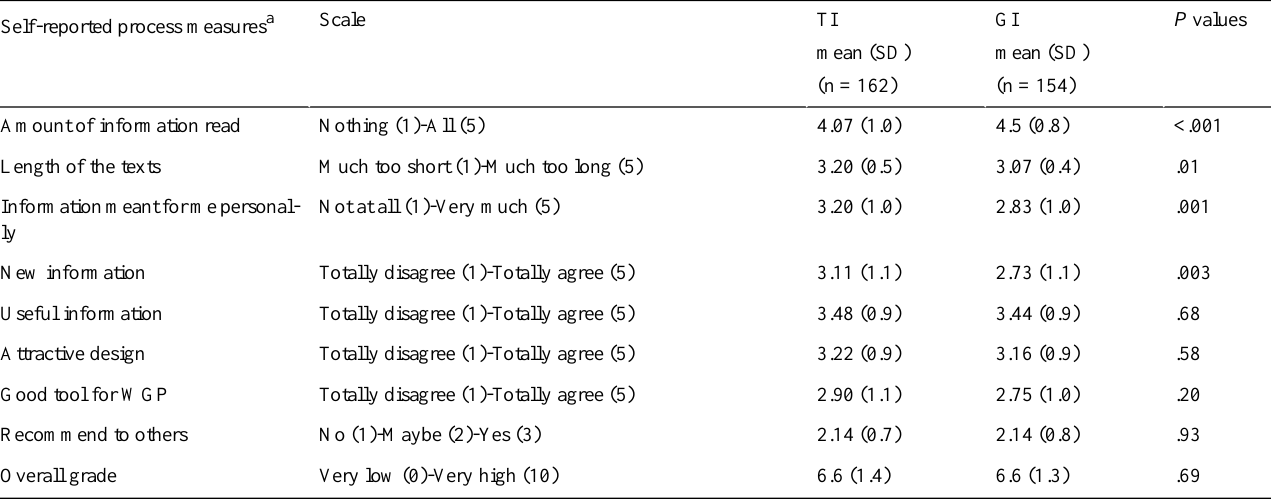
Table 6. Process measures; means (SD) of appreciation of general information intervention and tailored information intervention, self-reported at 1-month post intervention, and t tests for differences between these groups.